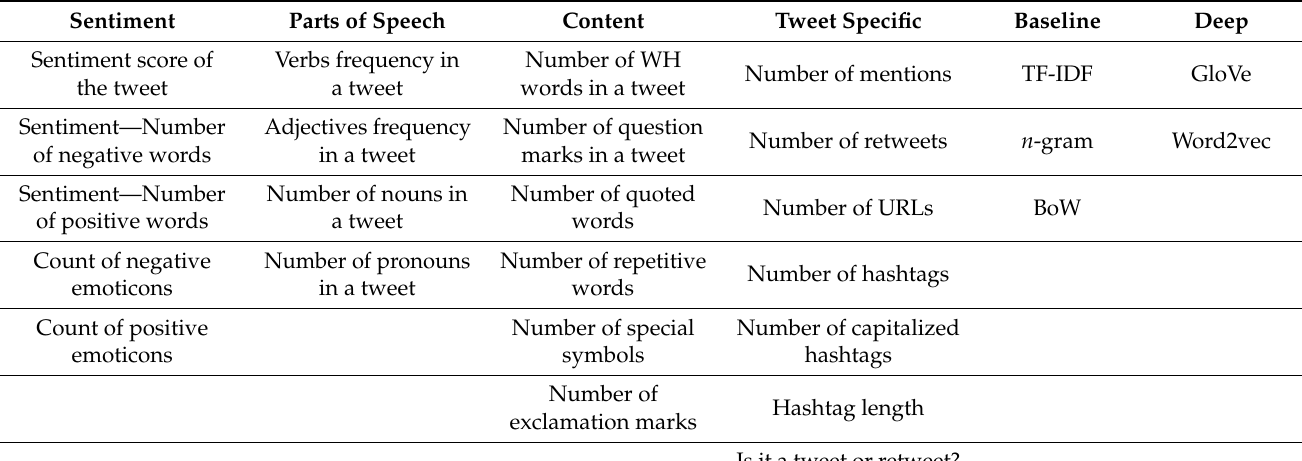
Table 3. Feature engineering for